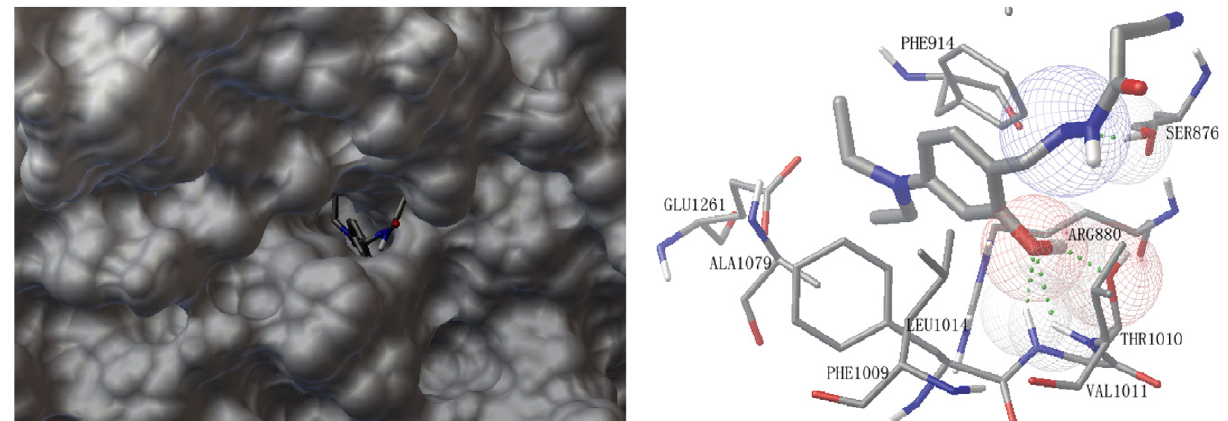
Figure 3. 3D (left) and 2D (right) binding mode of 1 with the active site of XO. Hydrogen bonds are shown as dashed